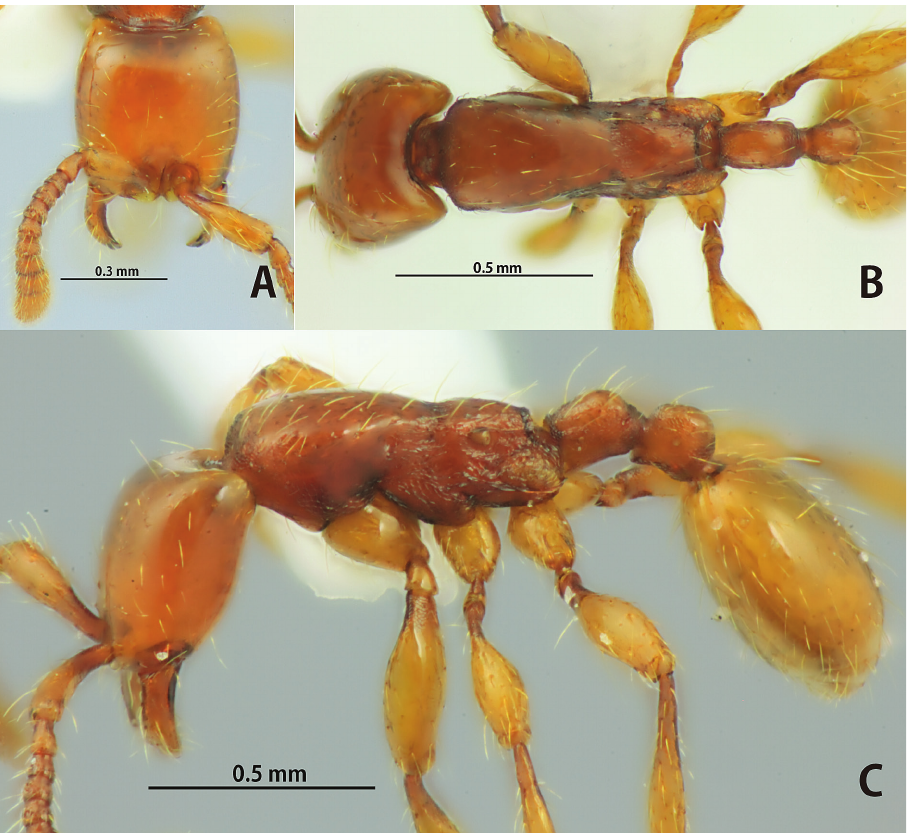
Figure 4. Aenictus concavus (holotype). A Head in full-face view B body in dorsal view C body in